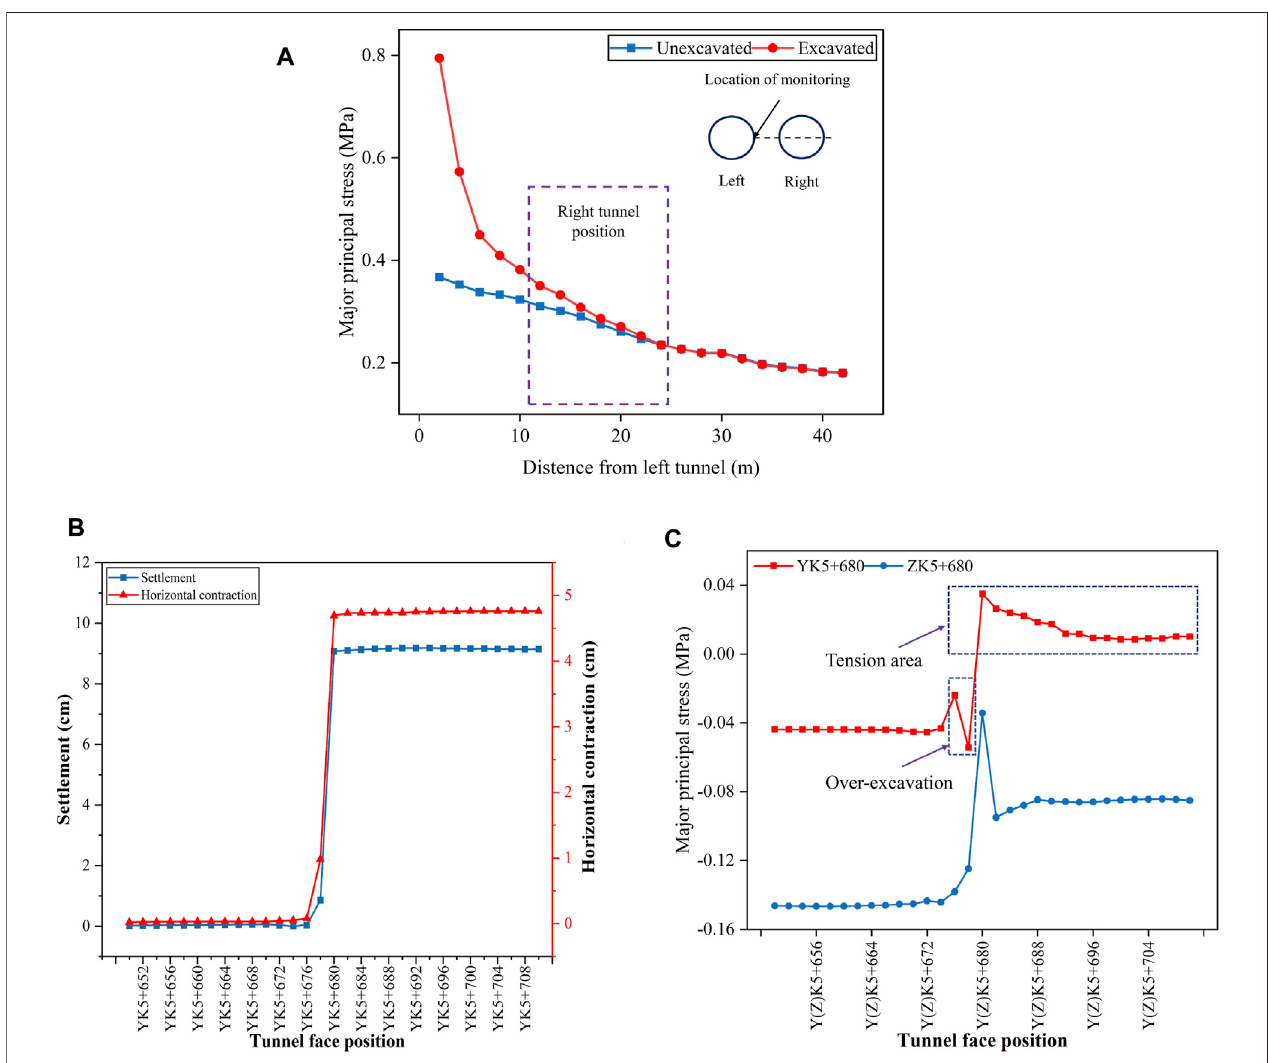
FIGURE 8 | Results of numerical simulation. (A) Differences of major principal stress between un-excavation and excavation. (B) Tunnel crown settlement and horizontal contraction at YK5+680. (C) Change of major principal stress at YK5+680 and ZK5+680.